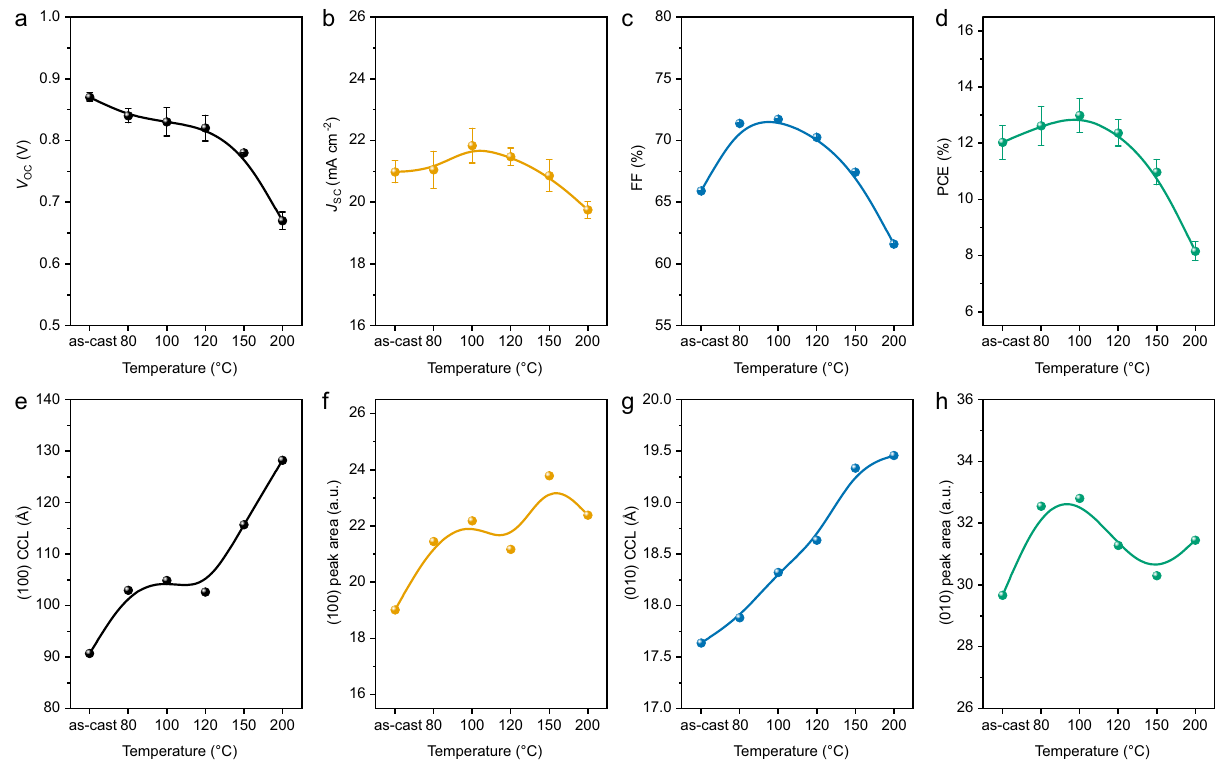
Fig. 9 Device performance and morphology parameters of PM6:ITIC-4F. PM6:ITIC-4F device performances of a V OC , b J SC , c FF, and d PCE (error bars represent the standard deviation over ten devices), and related fi lm morphology parameters of e (100) CCL, f (100) peak area, g (010) CCL, and h (010) peak area under different annealing